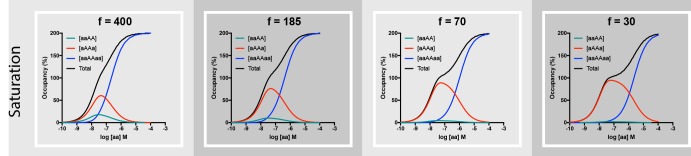
Broader range of f ratios and homobivalent ligand concentrations to illustrate the influence of this parameter on saturation profiles.The binding model and the ligand-emitted (fluorescence) signal intensity of the different binding modes is outlined in the legend of Figure 4 and Figure 4—figure supplement 1. Input parameters are similar to those used in Figure 4: r = 180 Å, k1 = 1.85⋅105 M−1min−1, k-1 = 0.0085 min-−1, k2 = 0.136 min−1. Investigated f values are given on top of the panel. Total incubation time is 120 min. Curves move from nearly- sigmoidal to outspokenly biphasic when f decreases. This phenomenon illustrates the fact that even higher [aa] is required for V2 to exceed V3 as the f parameter decrease.